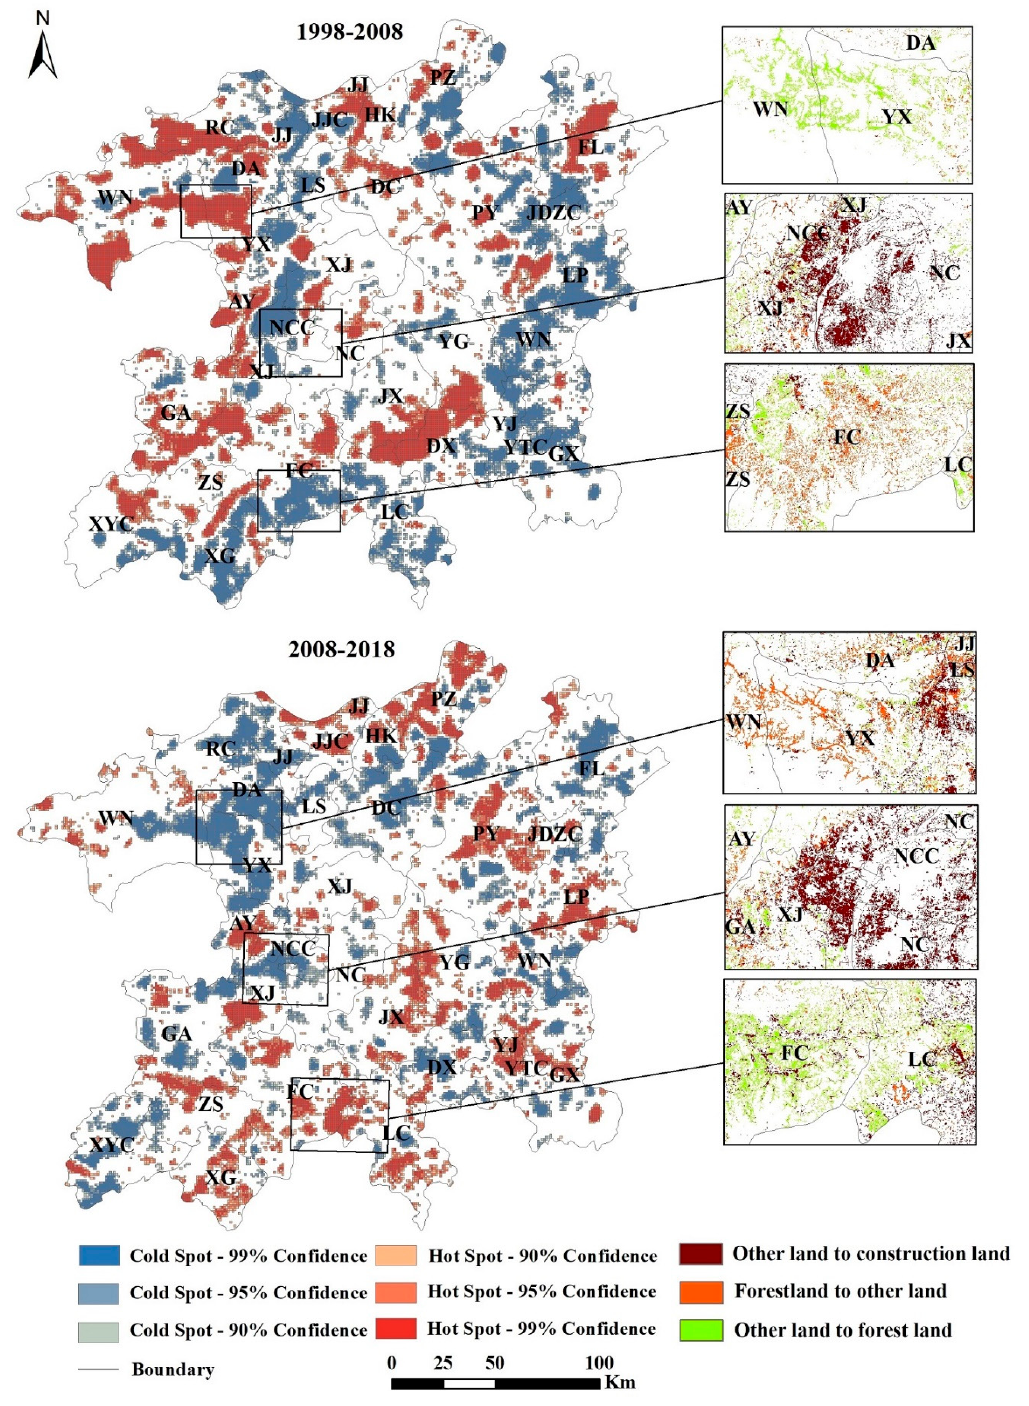
Figure 10. Cold spots and hotspots of habitat quality changes from 1998 to 2018 in the PLEEZ. Notes: The PLEEZ includes Pengze (PZ), Fuliang (FL), Hukou (HK), Jiujiang (JJ), Ruichang (RC), Jiujiang City (JJC), Poyang (PY), Duchang (DC), Wuning (WN), Dean (DA), Lushan (LS), Yongxiu (YX), Leping (LP), Xinjian (XJ), Yugan (YG), Anyi (AY), Nanchang (NC), Wannian (WN), Jinxian (JX), Gaoan (GA), Guixi (GX), Yujiang (YJ), Dongxiang (DX), Fengcheng (FC), Yingtan (YT), Linchuan (LC), Zhangshu (ZS), Xinyu (XY), Xingan (XG), Nanchang City (NCC), and Jingdezhen (JDZ).